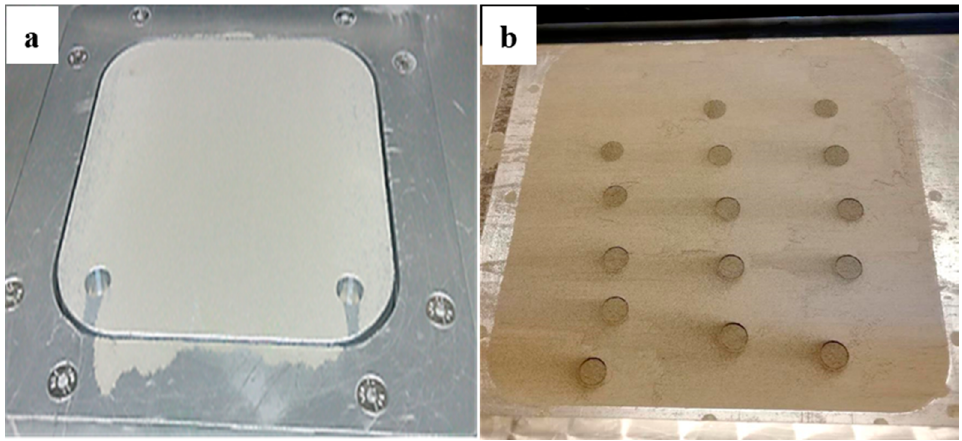
Figure 8. The typical spreading ( a ) and forming ( b ) tests of SiC/PVB composite powders with 3 wt. % binder addition using the 3D printing machine.